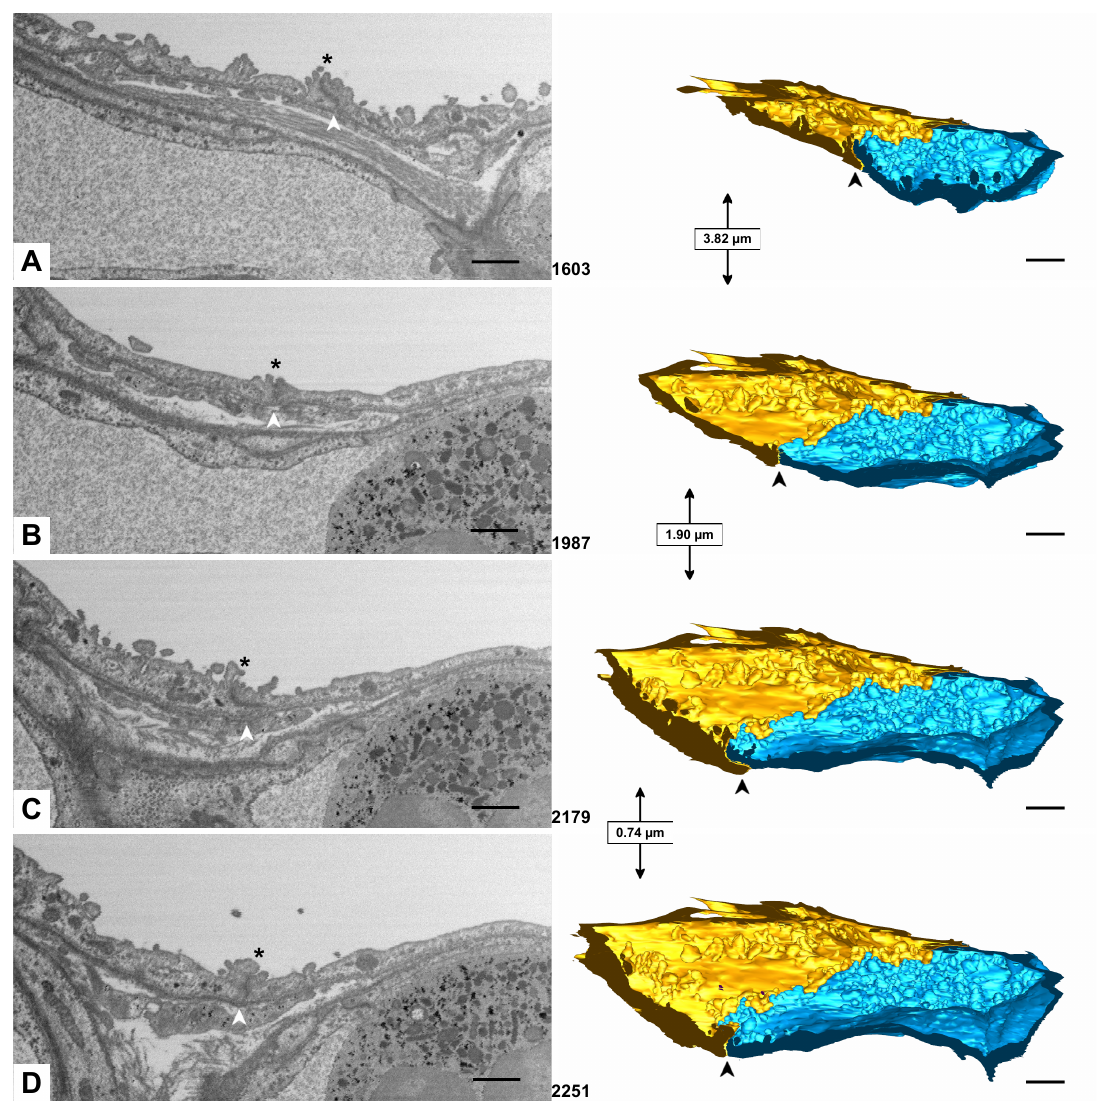
Figure 6. AE1/AE1 contact. ( A – D ) show the x-plane reconstructions 1603, 1987, 2179 and 2251 of the data set (lateral view on the dataset) on the left side of the panel and a clipped model of the yellow and blue AE1 cell domains on the right side of the panel. The transect plane in the foreground corresponds to the EM plane on the left side. The site of cell contact is indicated by arrowheads. The distance between the different transect planes is indicated in micrometers between the models. Note how the yellow AE1 cell domain slips under the blue cell domain in A and C while the cell domains in B and D meet each other just edge to edge. Note also the bulging of the cell domains into the alveolar lumen at the contact site (asterisks on the EM images). Scale bars: 1 µ